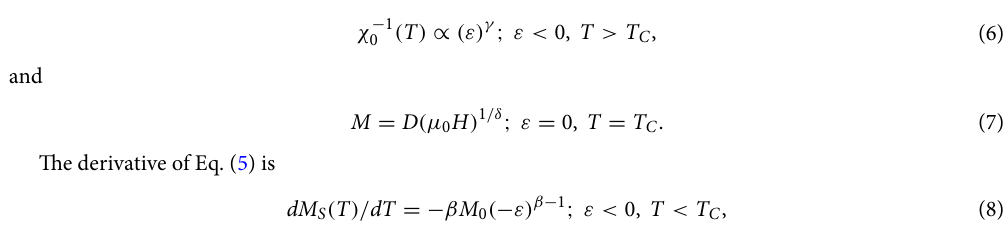
The derivative of Eq. (5) is